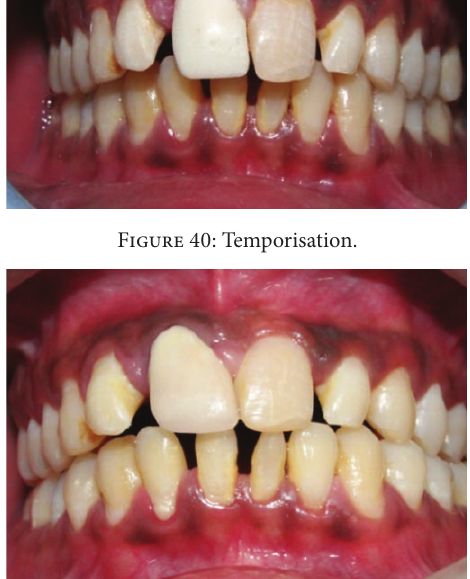
Figure 41: PFM crown cementation.